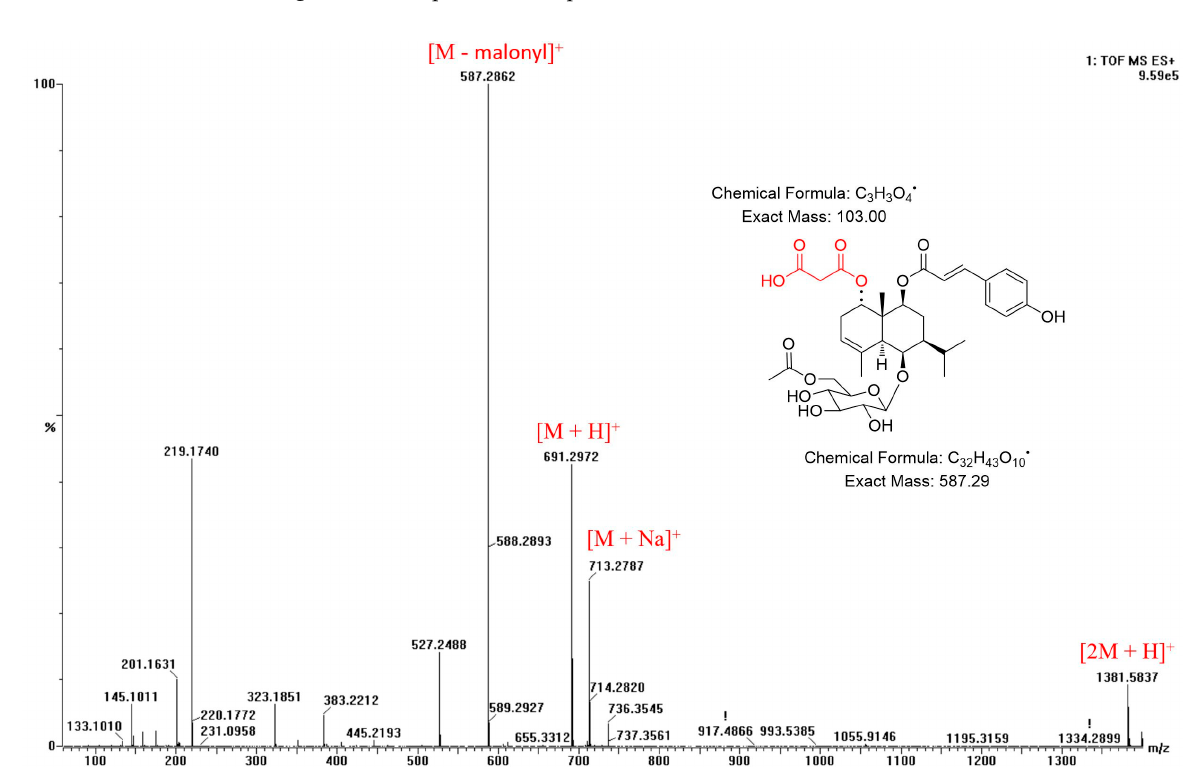
Figure 5. HRESIMS fragment data (positive) of compound 2 .